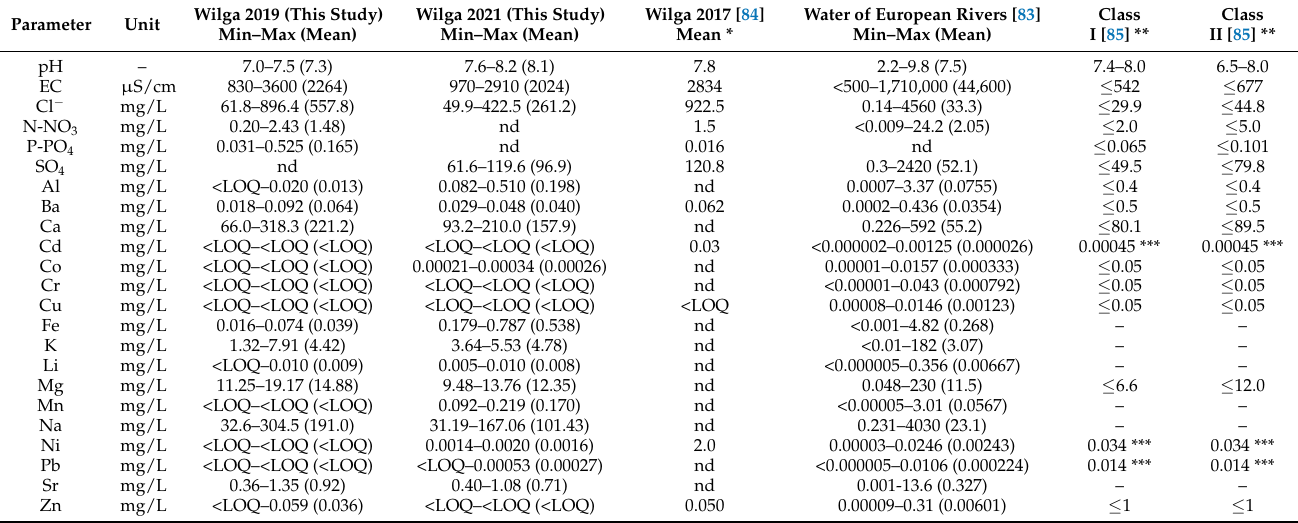
Table 1. Statistical parameters in the Wilga River water (2017, 2019 and 2021), European rivers and permissible levels of the selected